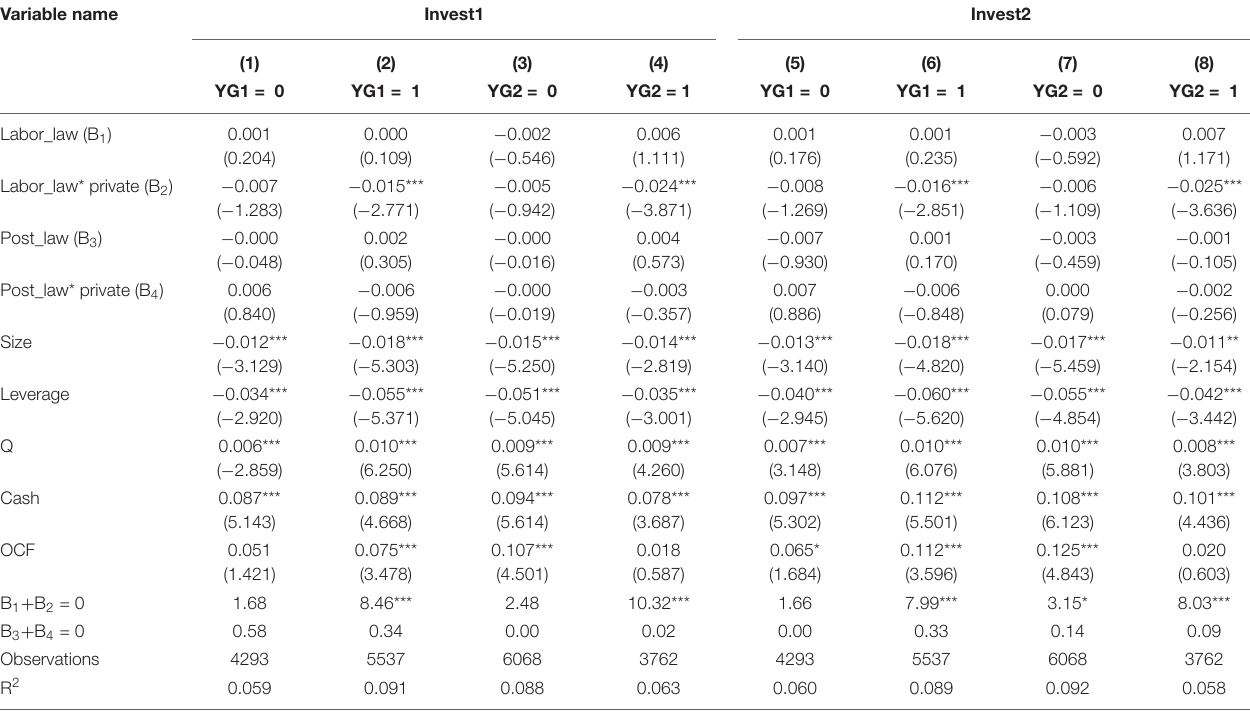
TABLE 3 | The Labor Protection Law (LPL), property right nature and enterprise investment − based on the grouped test of listed company employees.